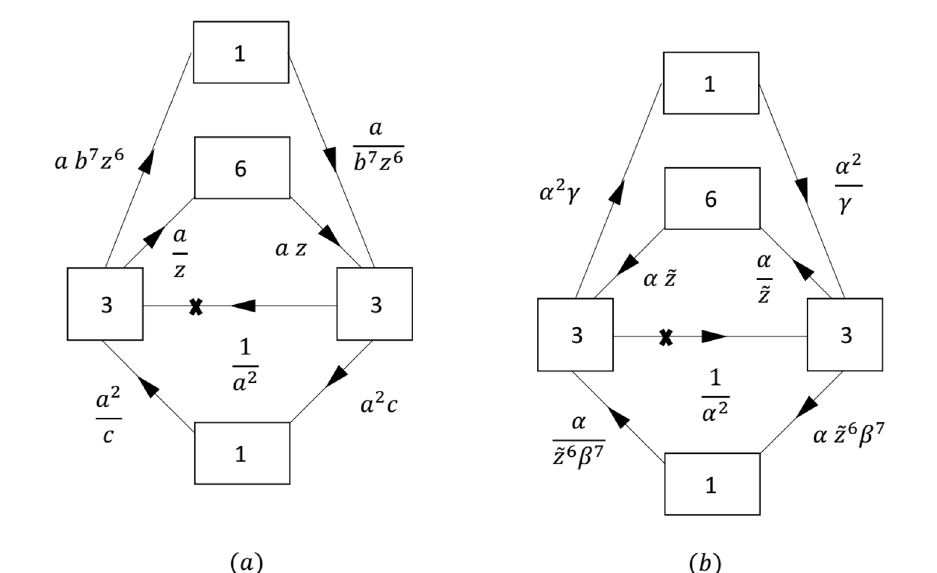
Figure 19 . The theories associated with the compactification of the SU(10) 5 d SCFT on a tube. Here both (a) and (b) describe the same tube, differing only by a reflection. Charges under the global symmetries are denoted using fugacities. Here we have also split the 7 chirals on the two sides to 6 + 1 , and correspondingly only the SU(6) × U(1) subgroup of the SU(7) global symmetry is manifest in the